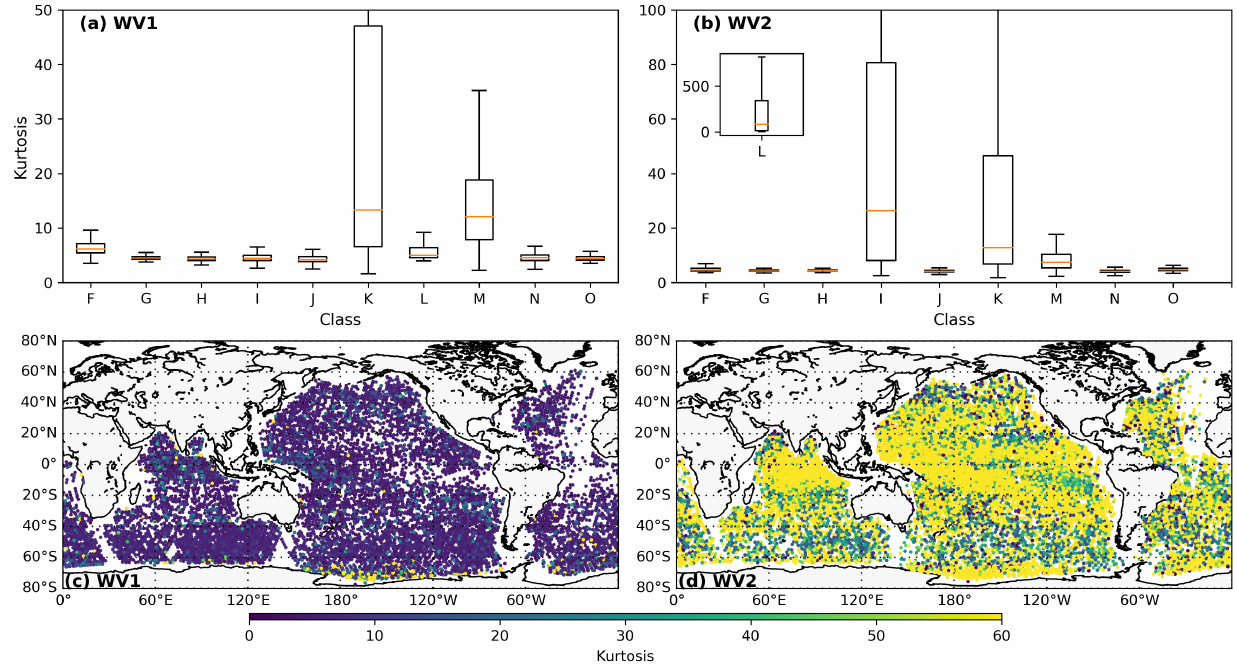
Figure 6. The same as in Figure 4 but for the